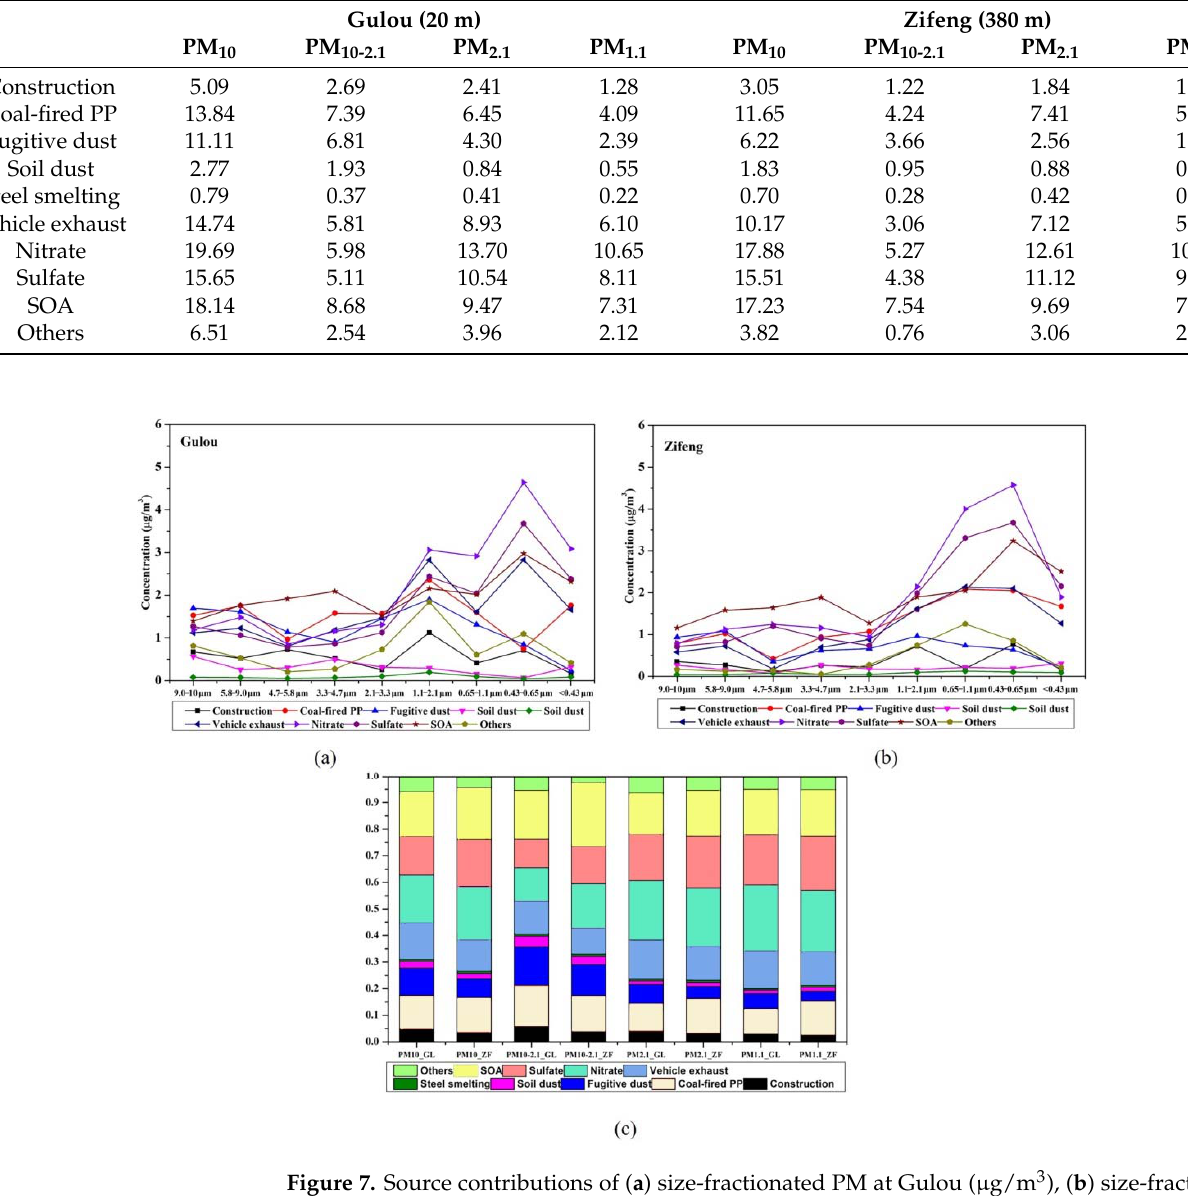
Figure 7. Source contributions of ( a ) size ‐ fractionated PM at Gulou ( μ g/m 3 ), ( b ) size ‐ fractionated PM at Zifeng ( μ g/m 3 ), and ( c ) PM 10 , PM 10 ‐ 2.1 , PM 2.1 , and PM 1.1 at both sites (100%).